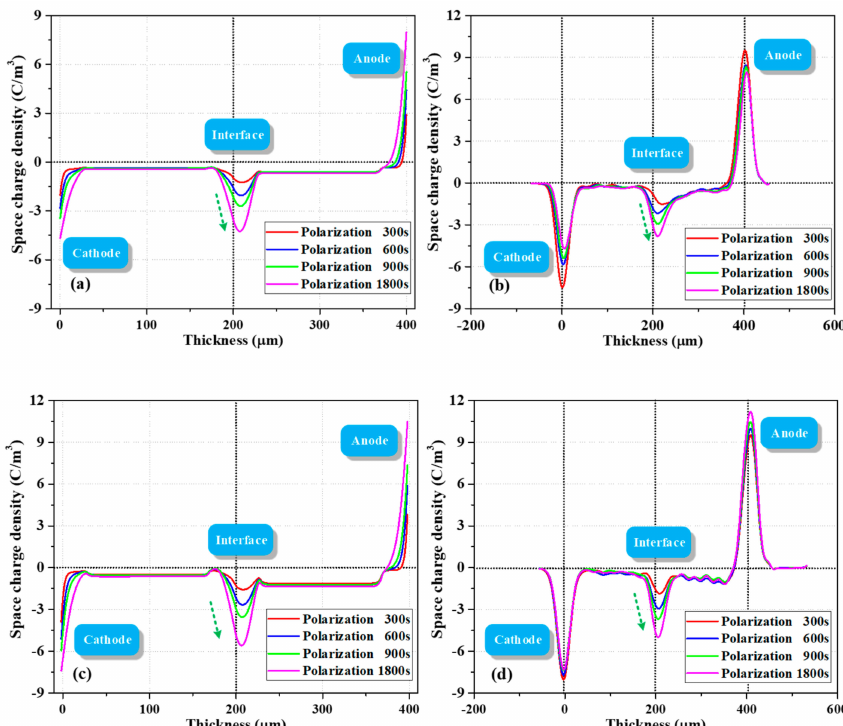
Figure 9. Comparison between simulation and test results of charge dynamics in PET–PET samples under 10 kV / mm. ( a ) Simulated and ( b ) corresponding results for 720 h, and ( c ) simulated and ( d ) corresponding results for 2900